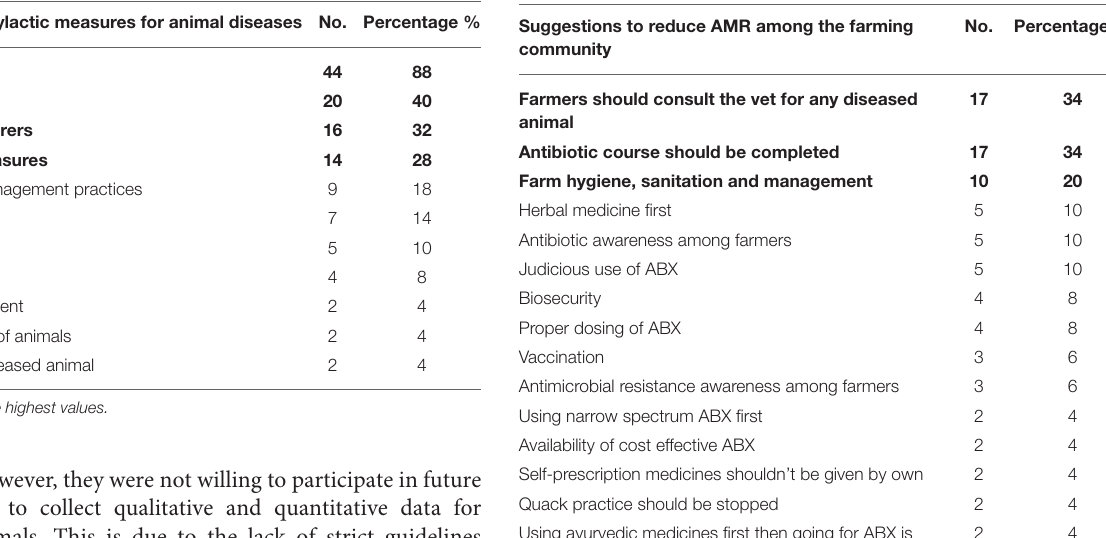
TABLE 6 | Veterinarian’s suggestions for reducing antimicrobial resistance in farming